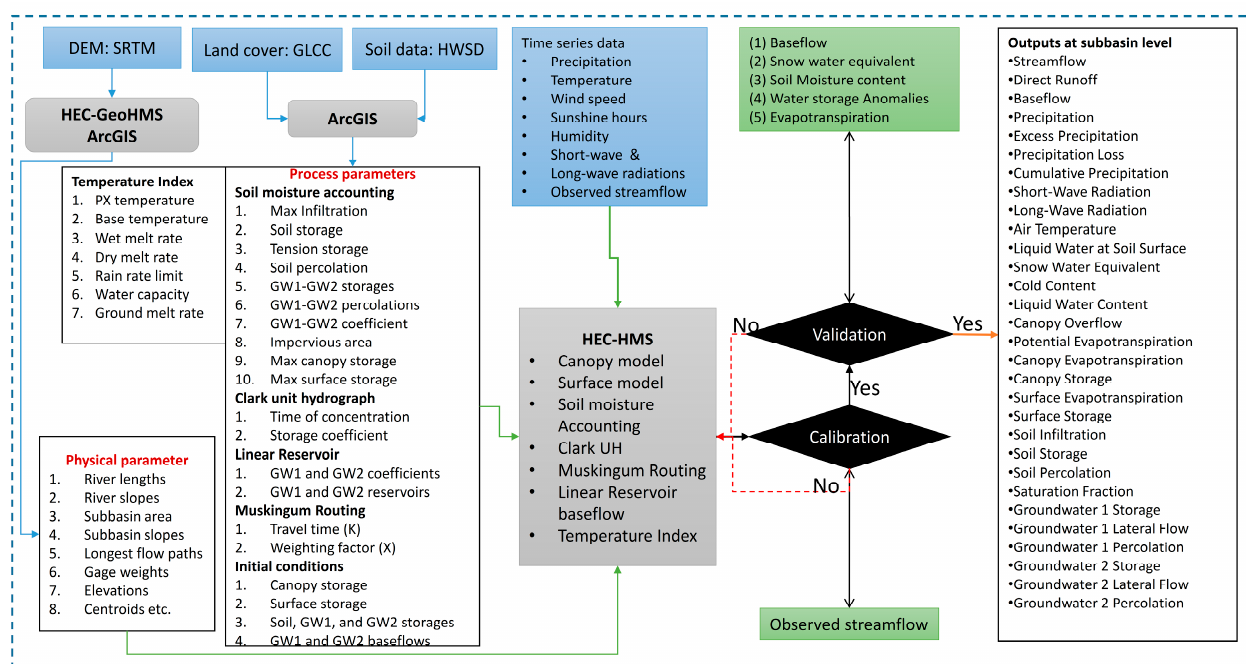
Figure 2. The whole procedure in the development of the hydrological model (HEC-HMS).